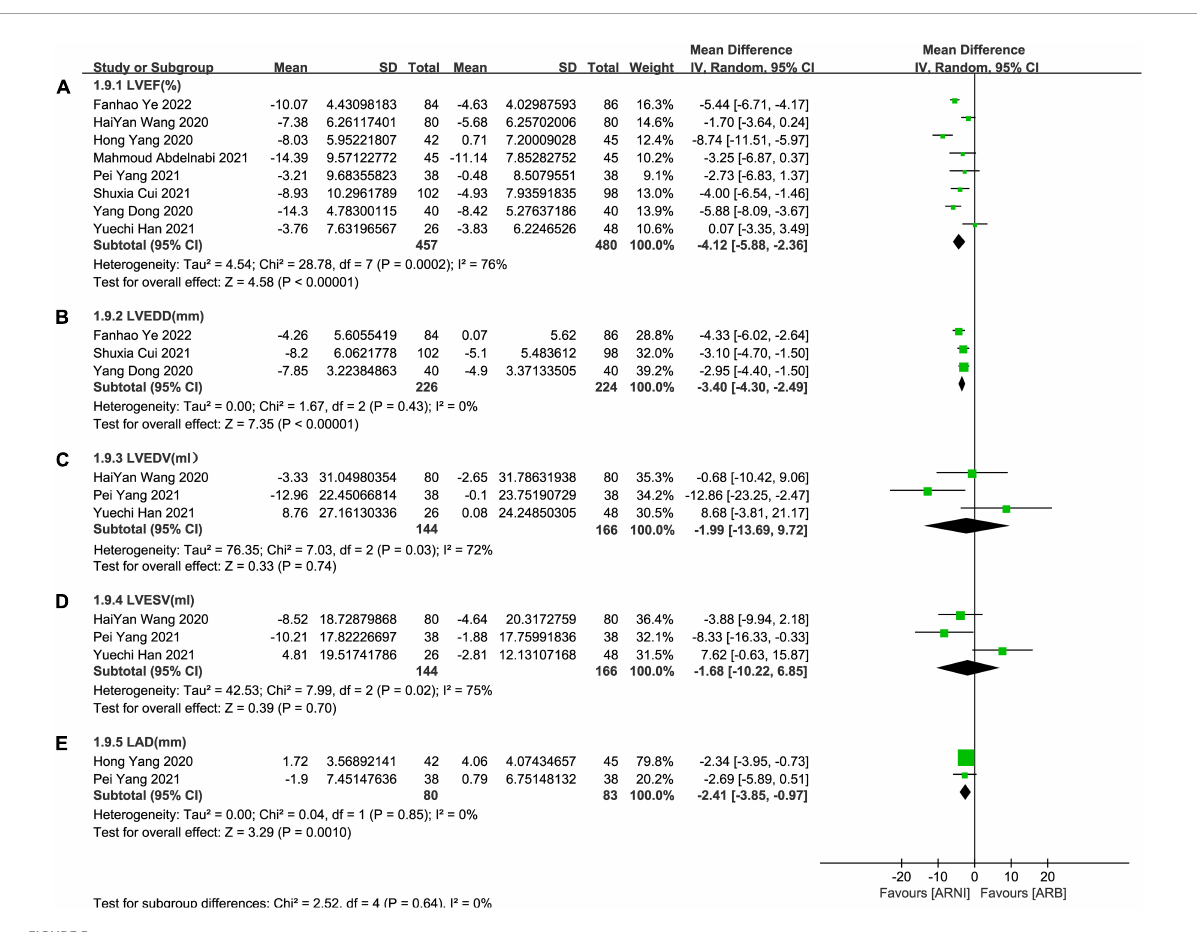
(MD: − 1.99 ml, [95%CI: − 13.69, 9.72]; Figure 5C ) and